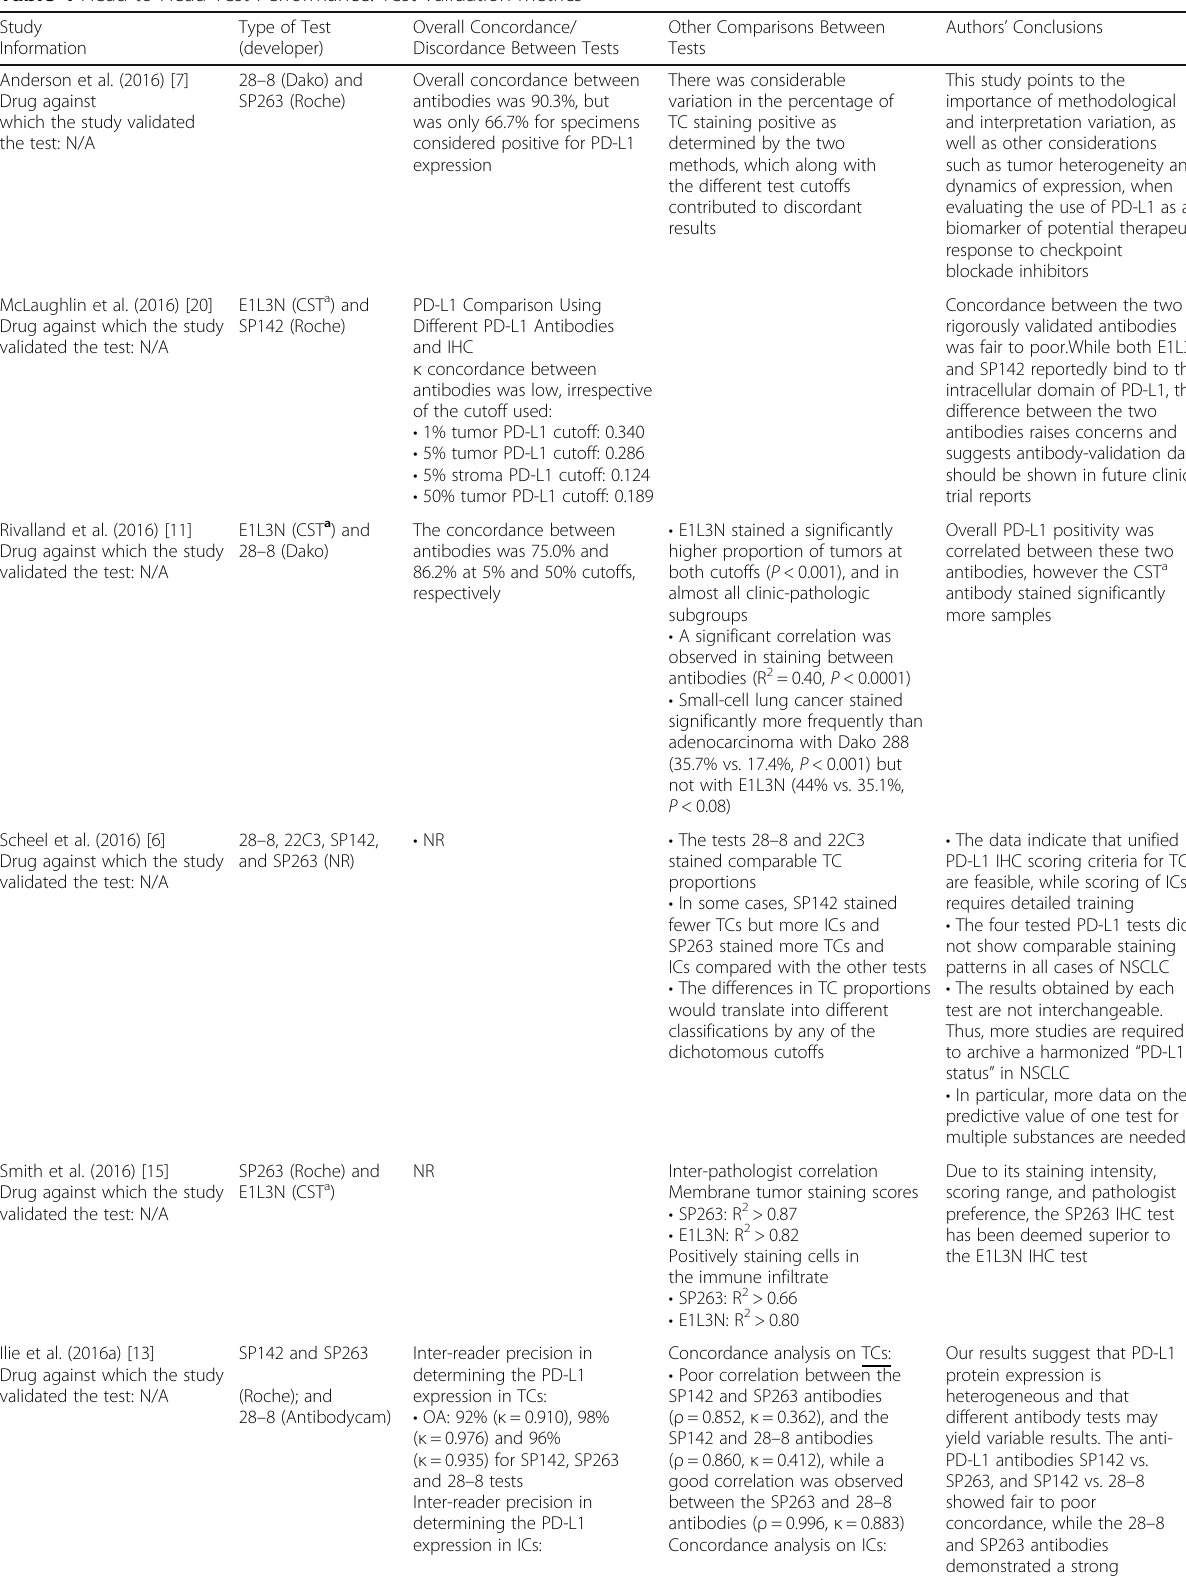
Table 4 Head-to-Head Test Performance: Test-Validation